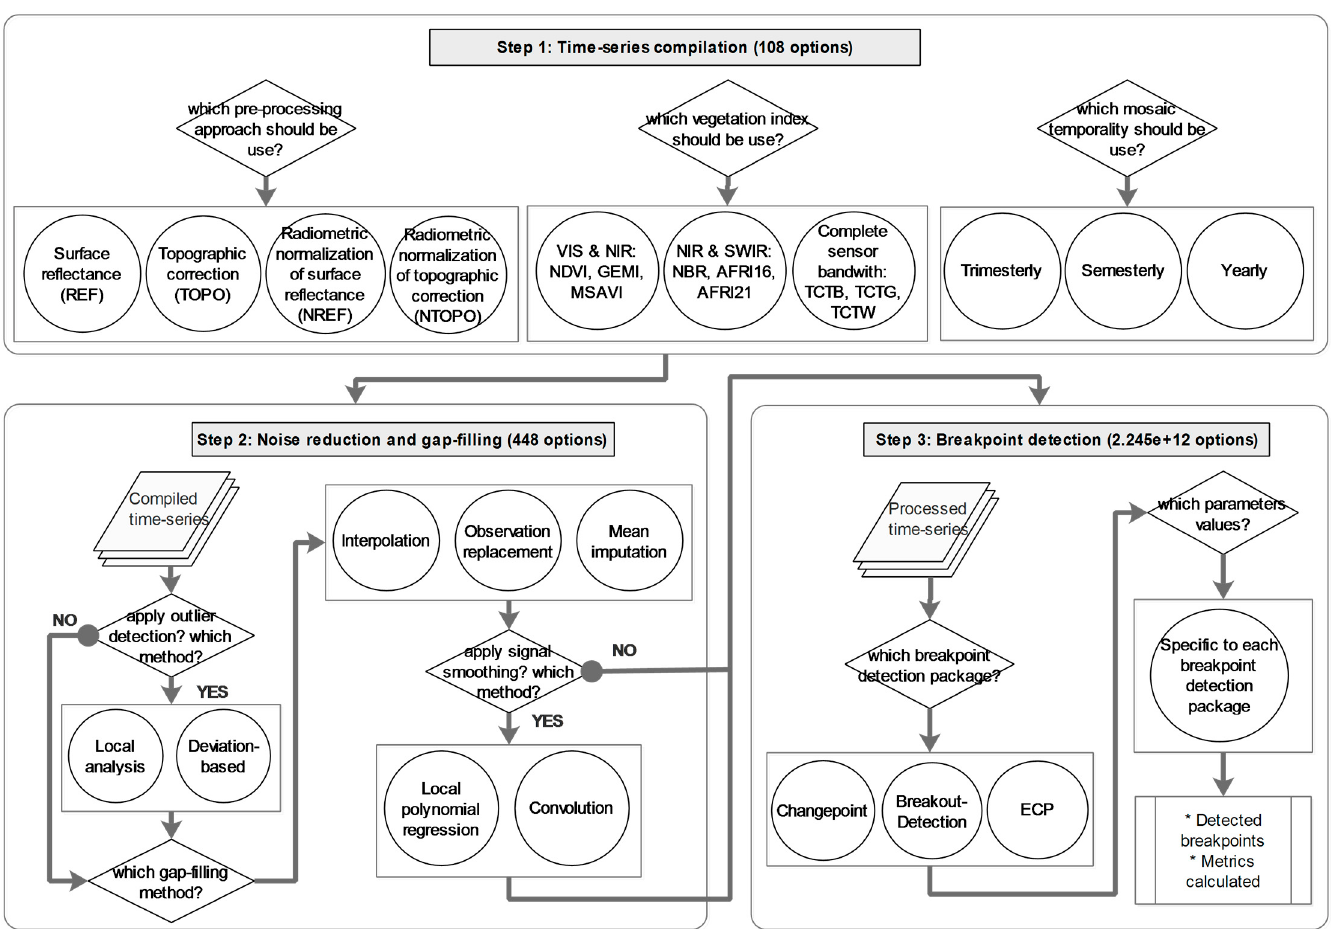
Figure 6. PCG Figure 6. PCG workflow.